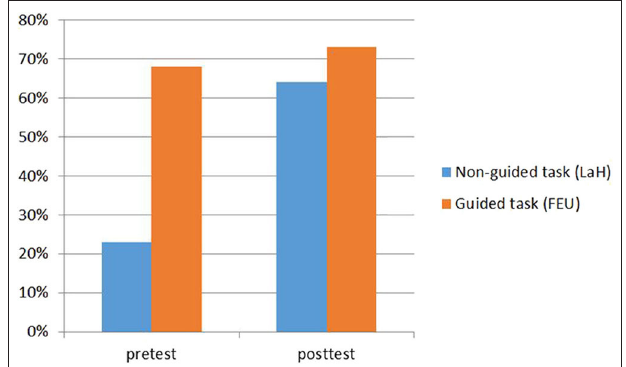
FIGURE 5 | Comparison of solution rates related to two different items (treatment group).